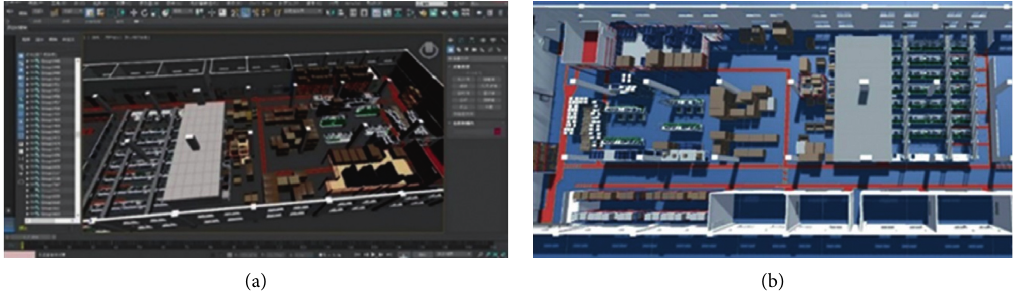
Figure 2: The 3D factory model. (a) Model in 3D Max. (b) Model in Unity.